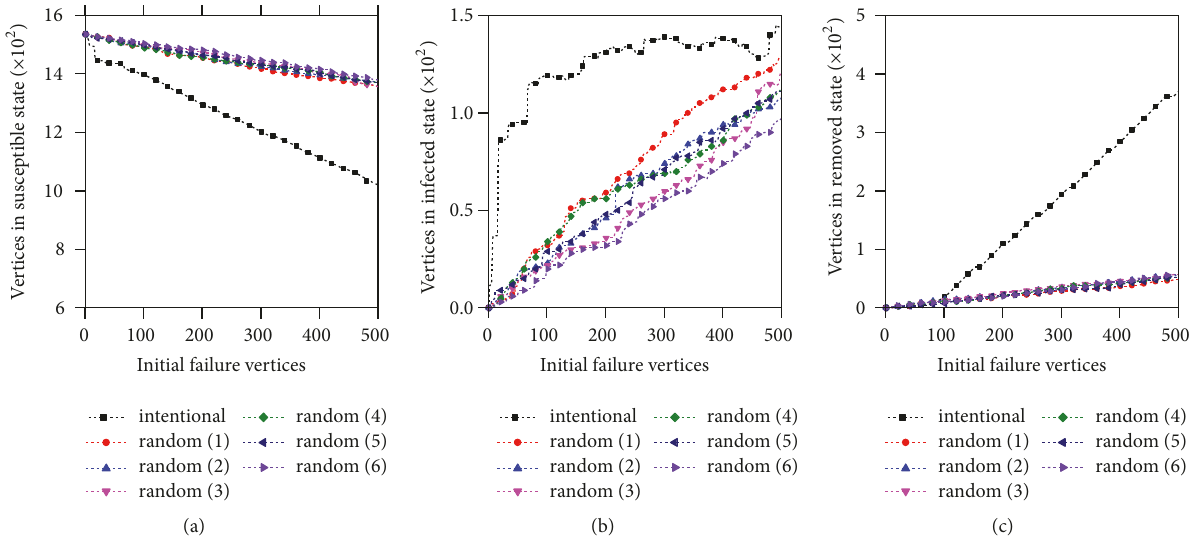
Figure 11: Crisis spreading when networks meet random failure and intentional attack (listed